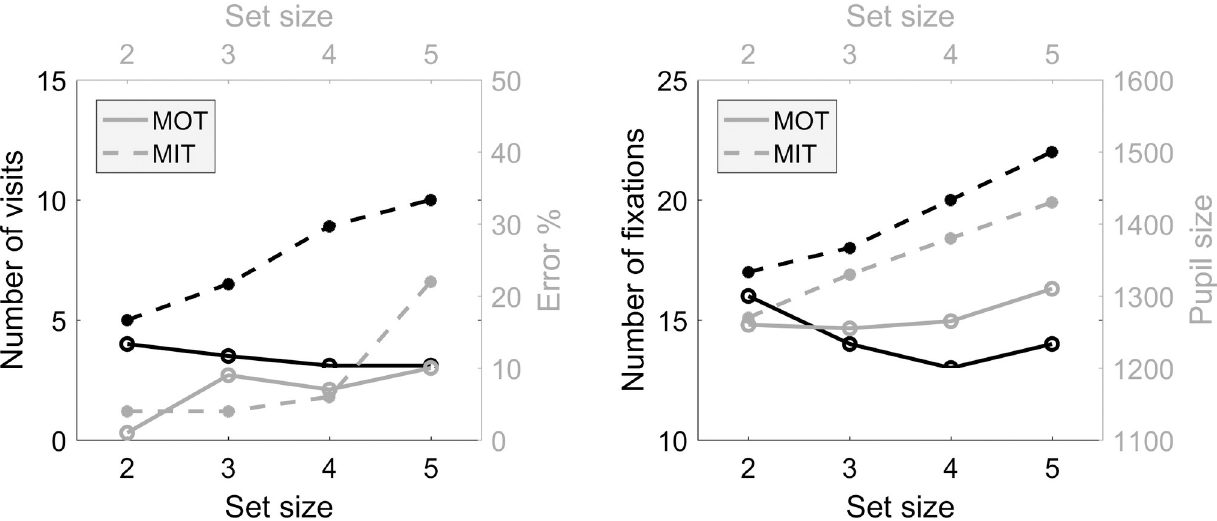
Fig 3. Comparing subjects’ performance in MOT and MIT tasks using the results from Experiment 3 of [12]. MIT, multiple-identity tracking; MOT, multiple-object tracking.